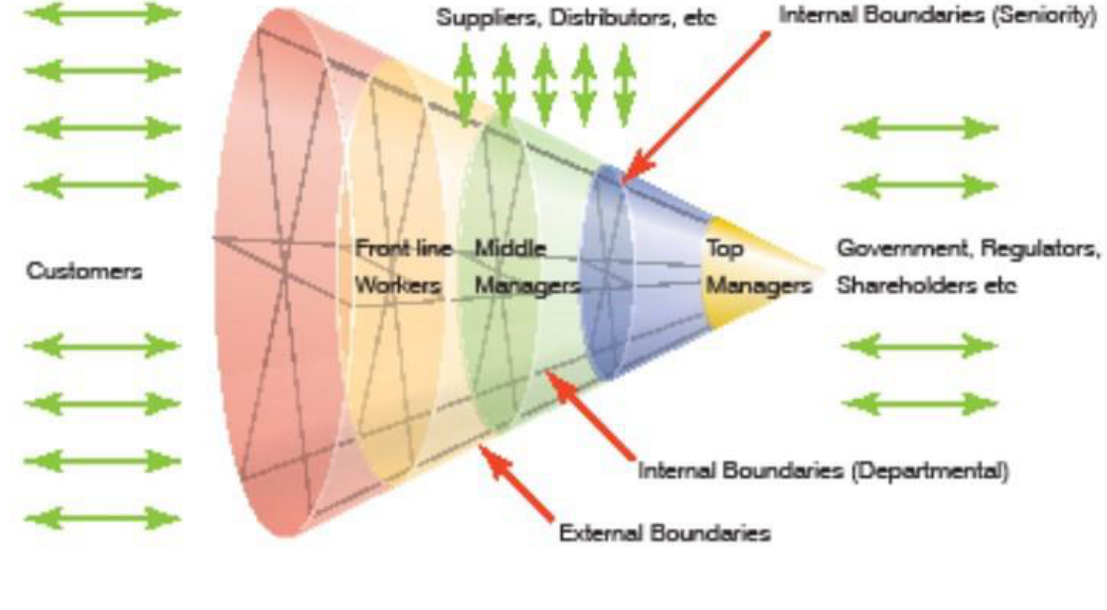
Figure 4: Organisational Cone (Hay, 2016, p.20)